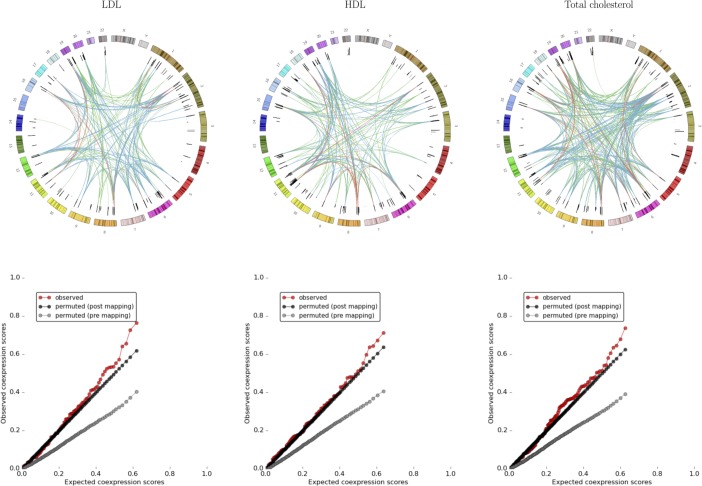
(Top panels) Circular plots of coexpression links between different locations on the genome, illustrating the spatial separation of highly-correlated regulatory regions. The coloured outer circle shows an end-to-end concatenated view of the human chromosomes. The black inner circle shows –log10 GWAS p-values for included SNPs. Links depict an association between two regulatory regions containing these SNPs and are coloured according to –log10(p) (line colour indicates –log10(p): red>3, blue> 2, green> 1.5). (Bottom panels) Quantile-quantile plots showing observed and expected coexpression scores. Expected coexpression scores are derived from circular permuted subsets of regulatory regions (post-mapping permutations; black circles) or SNPs chosen by circular permutations against the background of all SNPs genotyped in each study. Data are shown for high-density lipoprotein (HDL), low-density lipoprotein (LDL), and total cholesterol. See supplementary results for full results of all analyses.